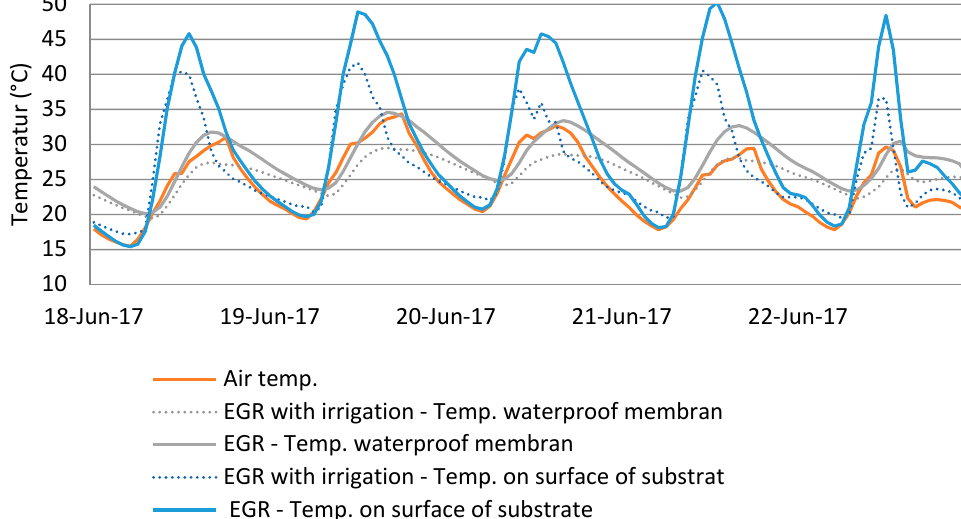
Figure 9. Logarithmic representation of the daily evaporation performance of irrigated green roofs over a period of 30 days.